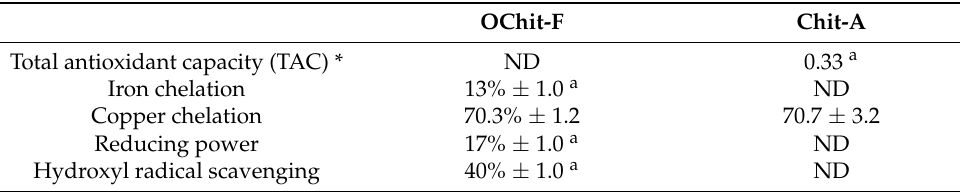
Table 1. Antioxidant activities of fungal oligochitosan (OChit-F) and animal chitosan (Chit-A).